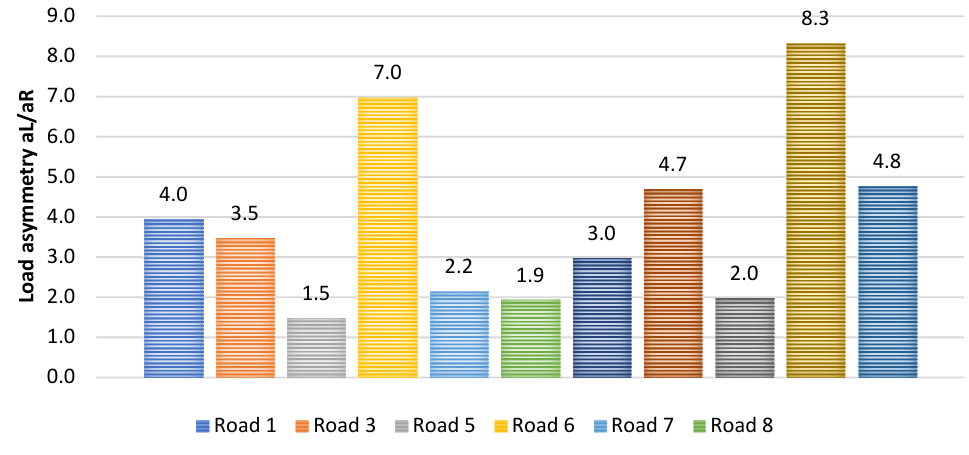
Figure 10. Asymmetric nature of the loads acting on the wheels of the vehicle (with symmetry being dL/dR = 1).